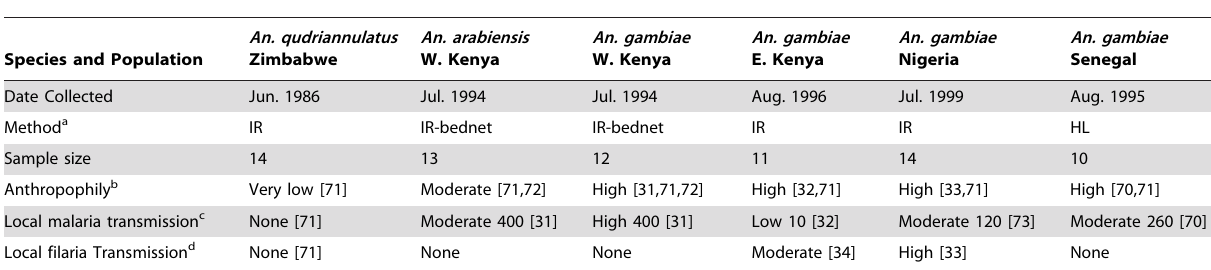
Table 2. Population characteristics in relation to exposure to human pathogens.